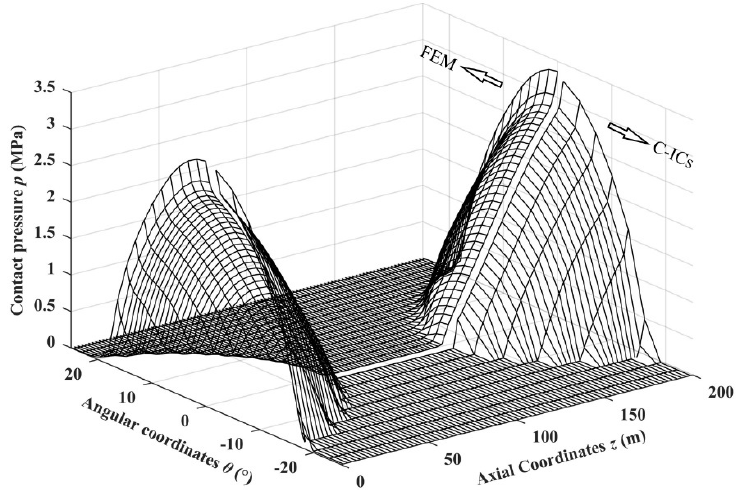
Figure 12. Comparison of contact area: ( a ) The approachment δ max changed from 0.01 mm to 0.1 mm; ( b ) the inclination Φ changed from 0.02° to 0.1°.